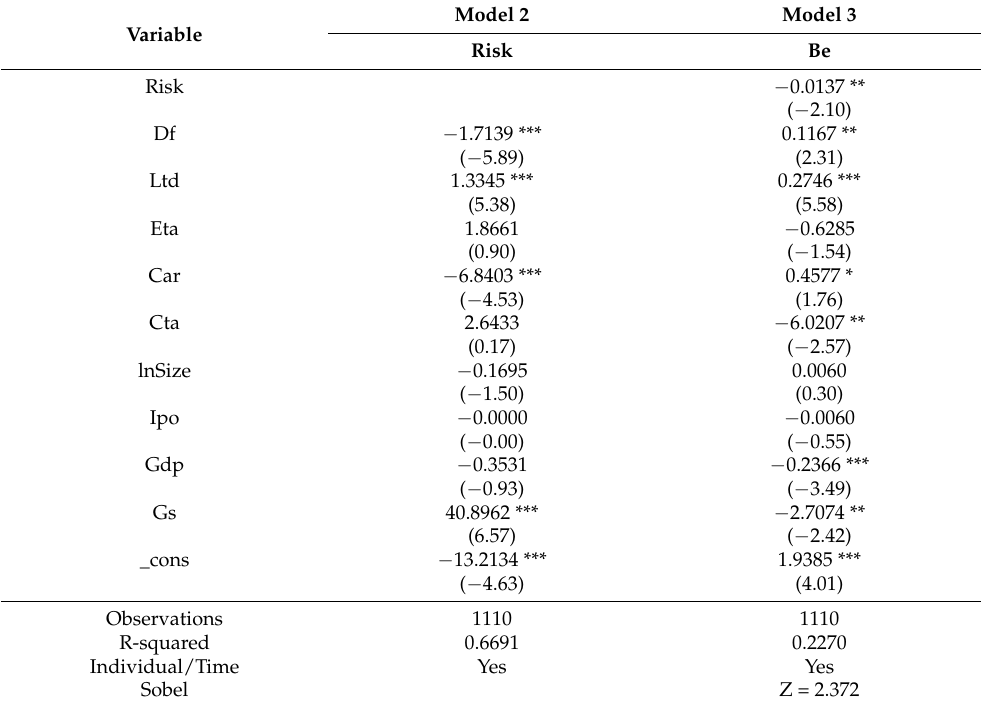
Table 6. Test of the mediating